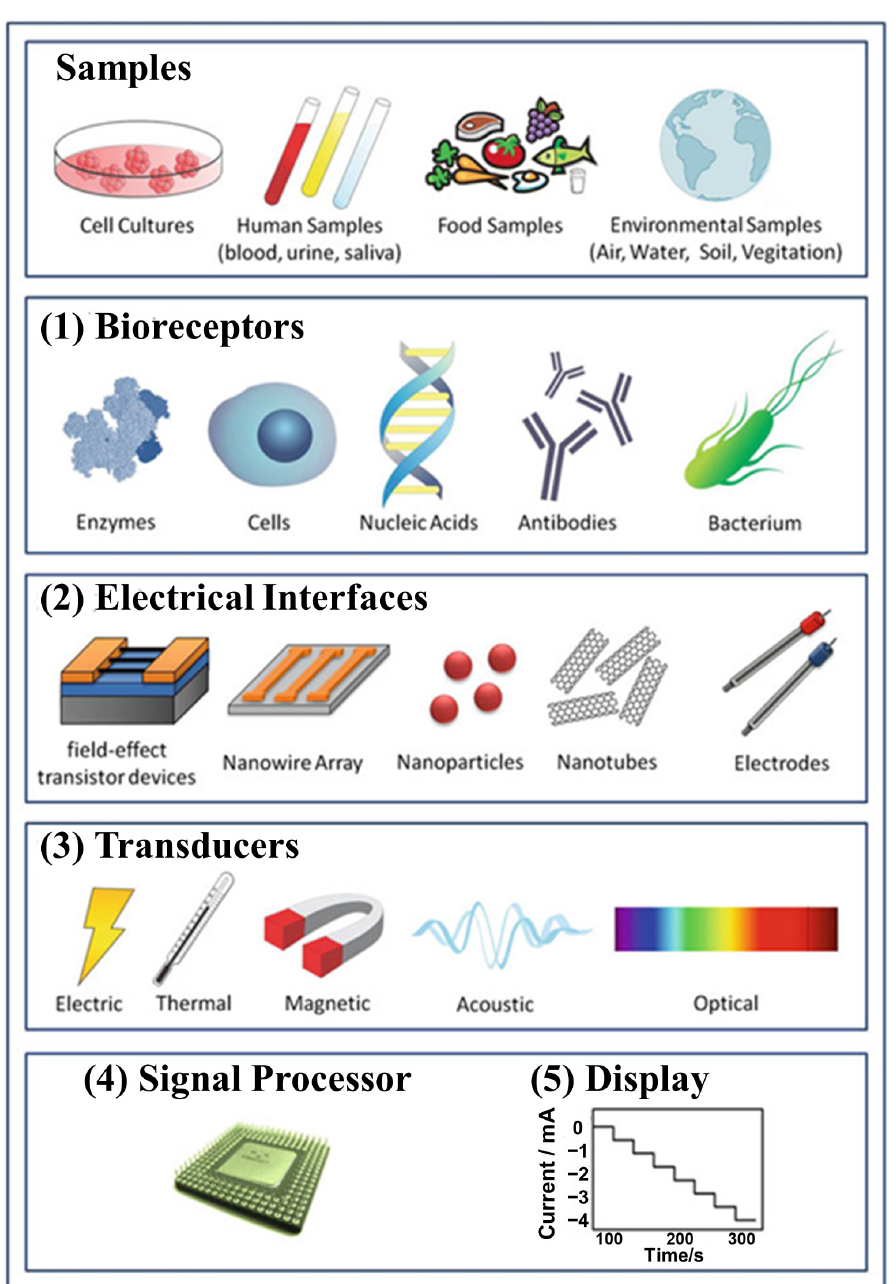
Figure 2. Various components of a typical nanobiosensor. Reproduced with permission from [22].